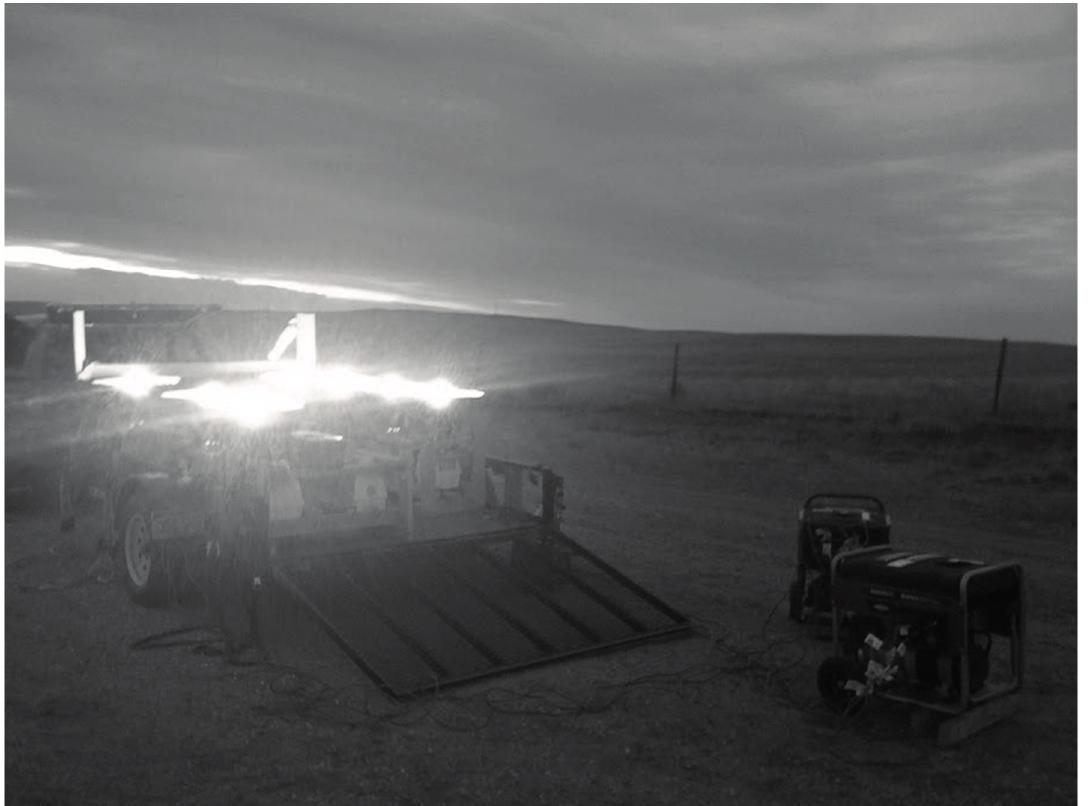
Figure 2. Seven (1000 watt) high pressure sodium lights in the utility trailer and the two generators used to power the lights in the